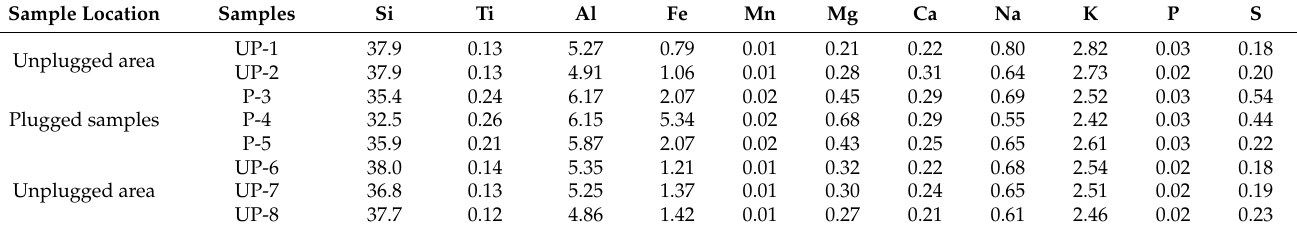
Table 1. The contents of major element in studied samples. Samples are entitled UP-(unplugged) or P-(plugged) in succession from top to bottom of sampling section.